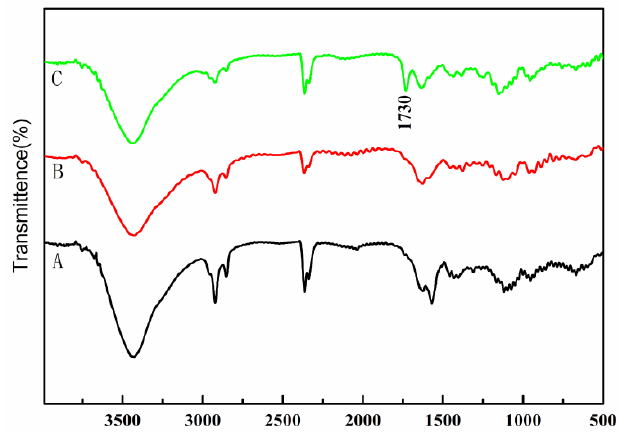
Figure 1. FTIR spectra of (A) untreated CF, (B) nitric acid and sulfuric acid-treated CF, and (C) MMA-treated CF.